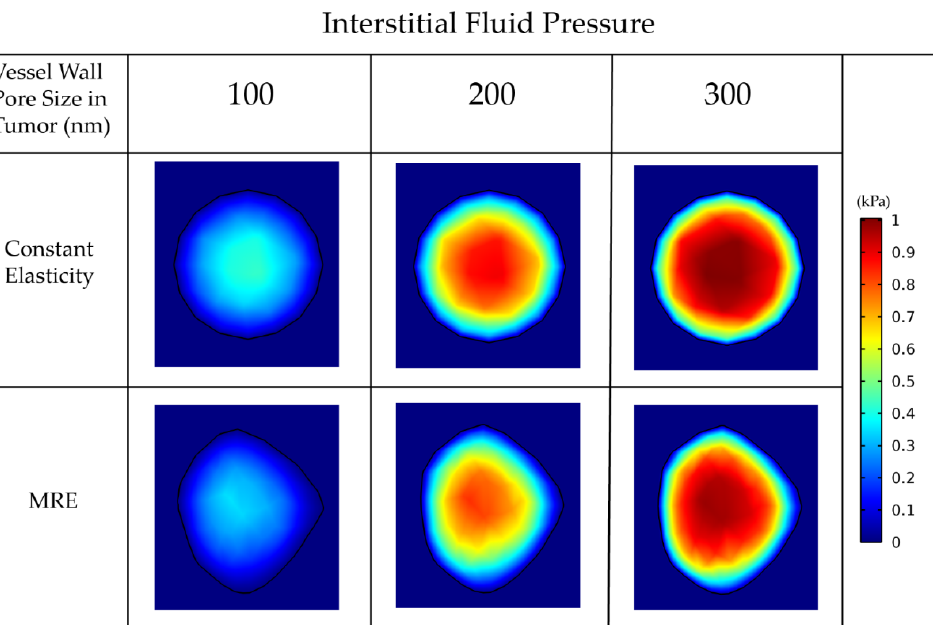
Figure 6. Interstitial fluid pressure for various vessel wall pore sizes. A comparison among the isotropic-constant elastic properties case and the anisotropic-elastography case (for patient 1) is shown.